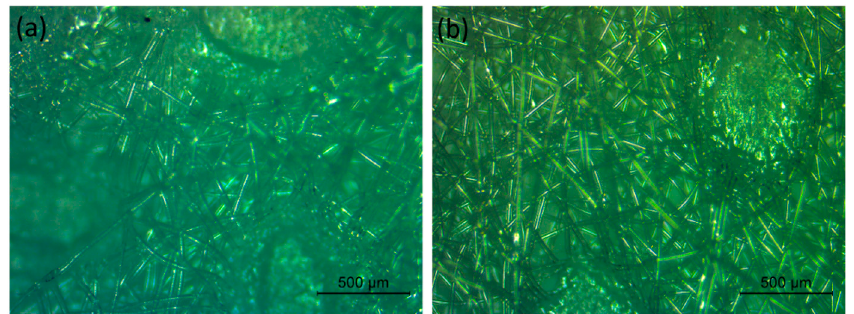
Figure 1. MS2 log reduction according to different UV-C energy densities achieved using two different UV-C lamps (30 and 55 W), different distances between lamp and sample (20, 30, 40, and 50 cm), and different exposure times (5, 6, 7, 8, 9, and 10 min). ( a ) depicts the results obtained on the outer surface of the FFP2 respirator, whereas ( b ) comprises the results achieved at the inner layer of the respirator. MS2 bacteriophage inoculum titer was 1 × 10 12 PFU mL − 1 .